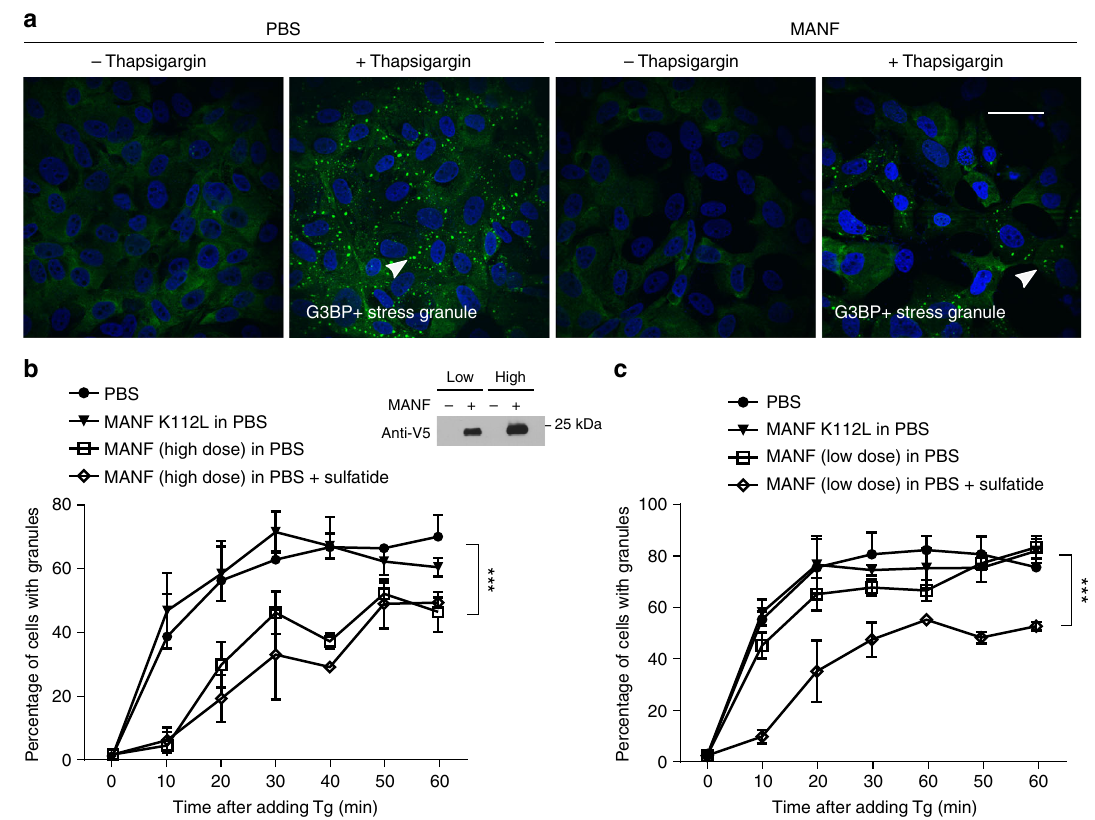
Fig. 6 Sulfatide-bound MANF alleviates ER stress in mammalian cells. a Exemplar confocal GFP fl uorescence images of Tg-induced stress granules in U2OS cells pretreated with conditioned MANF in PBS or control PBS. Scale bar, 40 µ m. b Quanti fi cation of the percentages of cells with granules induced by Tg in 60 min and high doses (10 µ l of conditioned medium/well) of Hs-MANF. A western blot for V5-tagged Hs-MANF indicates low and high doses of Hs- MANF used for experiments in b and c . c Quanti fi cation of the percentages of cells with granules induced by Tg in 60 min and low doses (2 µ l of conditioned medium/well) of Hs-MANF. Cells were deprived of serum for 48 h and then treated with conditioned PBS or MANF for overnight. Plots represent quanti fi cation of the data from 10 images per condition from three independent experiments. Scale bar, 15 µ m. *** indicates P <